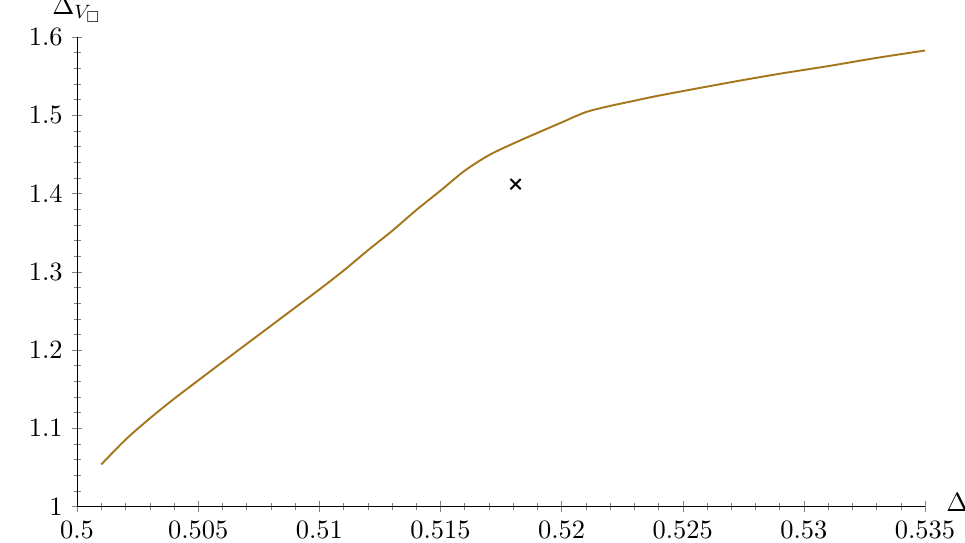
Figure 14 . Upper bound on the dimension of the (cid:12)rst V + a function of the dimension of (cid:30) for N = 2. The area above the curve is excluded. The x-marker indicates the position of the decoupled Ising